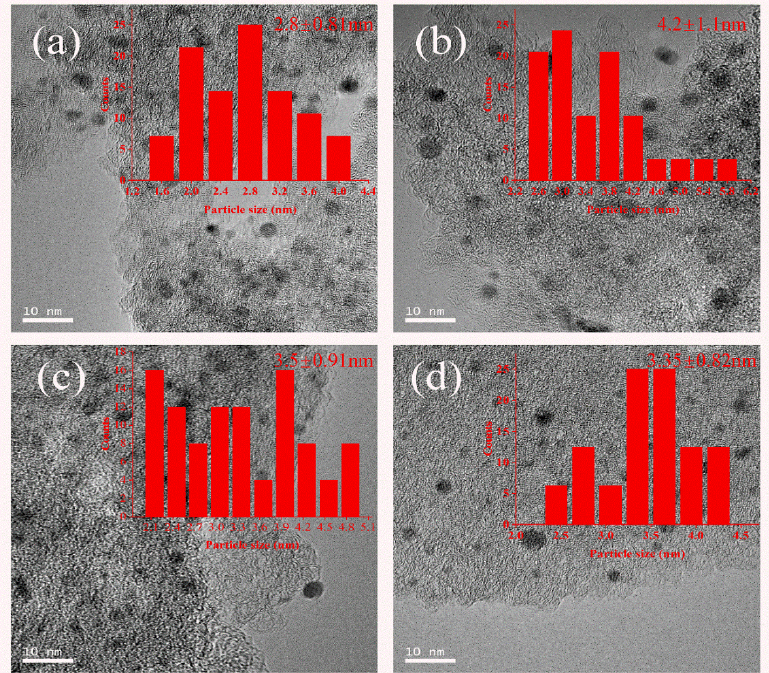
Figure 3. TEM images of fresh and spent catalysts ( a ) fresh 5 wt.% Pd/C catalyst; ( b ) spent 5 wt.% Pd/C ( c ) fresh 5 wt.% Pd(OH) 2 /C catalyst; and ( d ) spent 5 wt.% Pd(OH) 2 /C catalyst. In order to specifically understand the phase structure of the active components of the catalyst, the catalyst samples with 5 wt.% Pd(OH) 2 /C before and after the reaction were characterized by XRD. As shown in Figure 4, the XRD results show that for the fresh 5 wt.% Pd(OH) 2 /C catalyst, the diffraction peak at 34.0 ◦ is assigned to the PdO (101) crystal plane, the diffraction peak at 42.74 ◦ is assigned to the PdO (110) crystal plane, and the 55.02 ◦ diffraction peak is assigned to the PdO (112) crystal plane. For the spent 5 wt.% Pd(OH) 2 /C catalyst, the diffraction peak at 40.03 ◦ is attributable to the Pd (111) crystal face, and the diffraction peak at 68.05 ◦ is attributable to the Pd (220) crystal plane. After the reaction, the majority of diffraction peaks of PdO disappeared, indicating that the catalyst Pd(OH) 2 /C had a reduction reaction during the debenzylation action of HBIW. It can be calculated by MDI Jade 6 software that the average grain size of the spent 5 wt.% Pd(OH) 2 /C catalyst, the particle size was 3.5 nm. Although the average particle size of Pd before and after the reaction catalysts changed, the change range was small, indicating that the Pd particles did not have obvious agglomeration after the reaction.